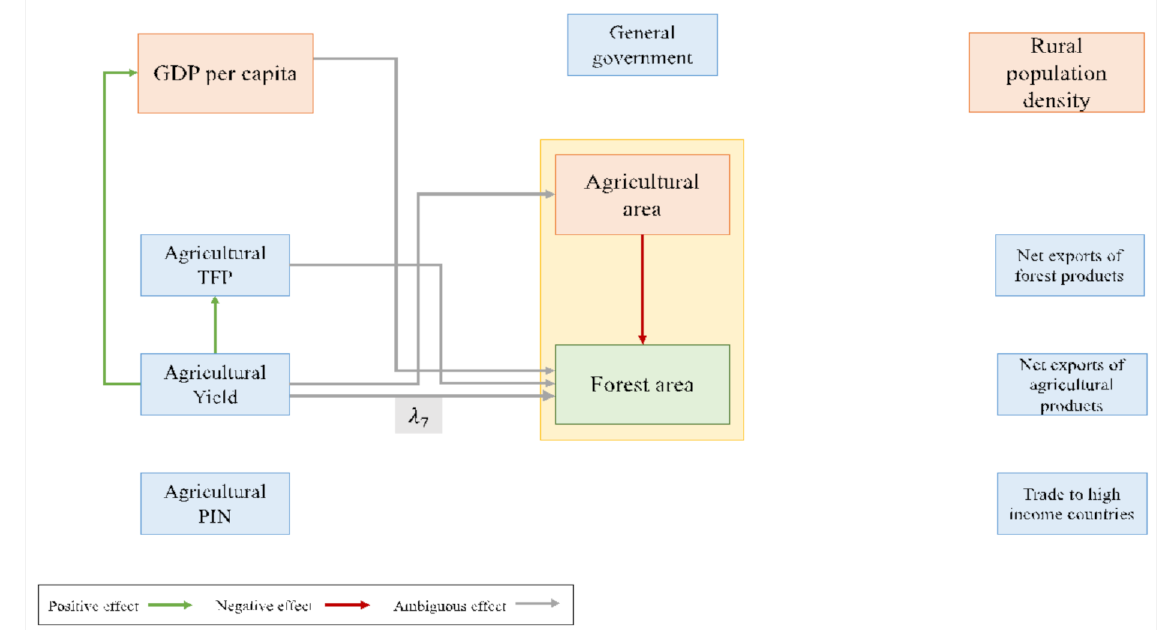
Figure A8. Estimating indirect effects of “agricultural yield” variable.